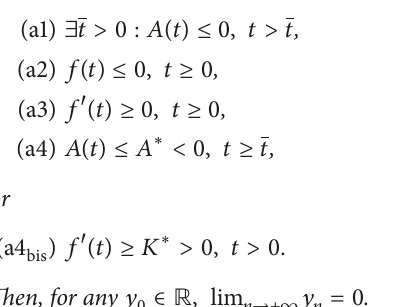
with 𝑐 1 , 𝑐 2 , and 𝑐 3 depending on the number of particles, their dimension, and the dynamic of the motion. For significative values of 𝑐 1 , 𝑐 2 , and 𝑐 3 hypotheses (a1), (a2), (a3), and ( a 4 bis ) of Theorem 15 are satisfied. Hence, we expect that in the numerical simulation of (43) obtained by using the Backward Euler method (44), any convergent numerical solution van- ishes at infinity. Figure 3 shows exactly this behaviour when integrating (43)–(46) with 𝑐 1 = 10 5 , 𝑐 2 = 10 −2 , and 𝑐 3 = 10 −4